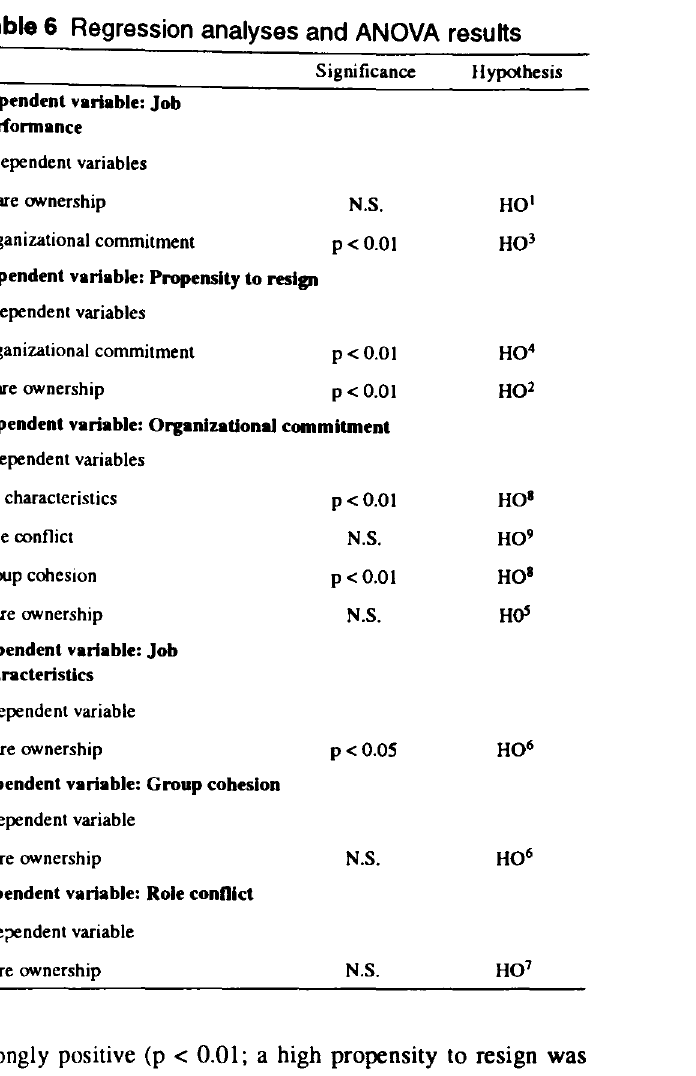
Table 6 Regression analyses and ANOVA results